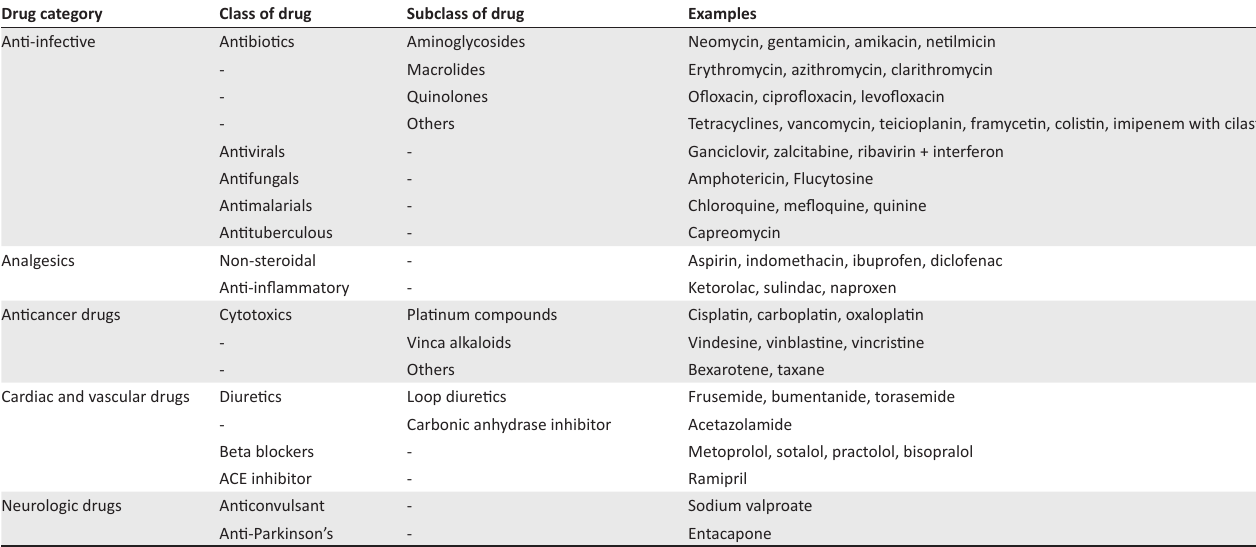
TABLE 1-A1: Drugs causing hearing loss as a side effect.